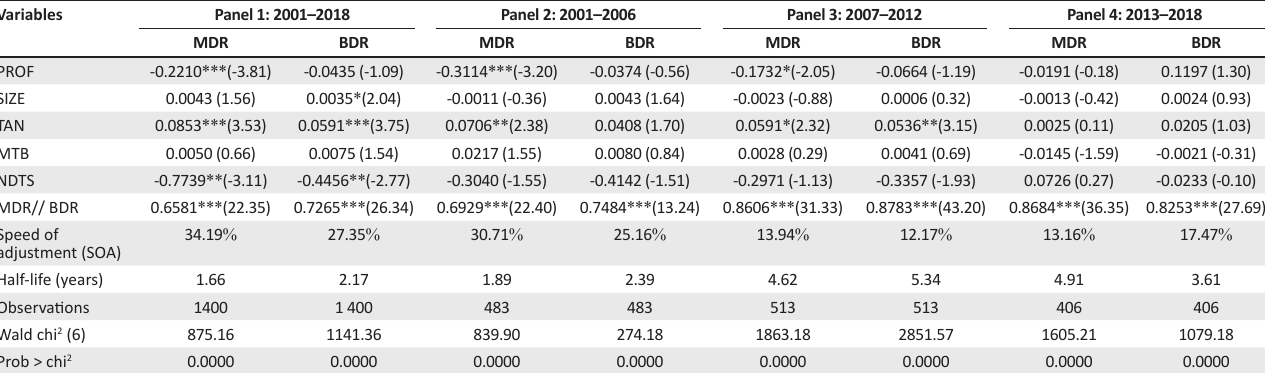
FIG URE 2: Full sample’s mean market-to-debt ratios of constrained and unconstrained firms TABLE 3: All panels’ random effects Tobit estimator regression estimates for empirical models 2 and 3 † using the full sample and the full subsamples. Variables